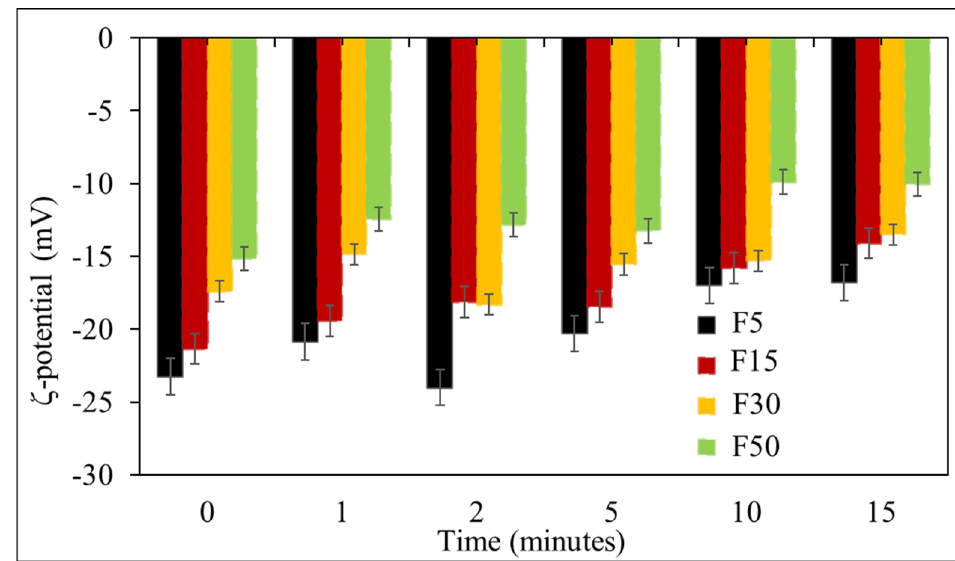
Figure 5. Effect of US time on ζ -potential of blank NLCs. Table 2. Effect of HSH time on the formulation of blank F30 NLCs. Formulation